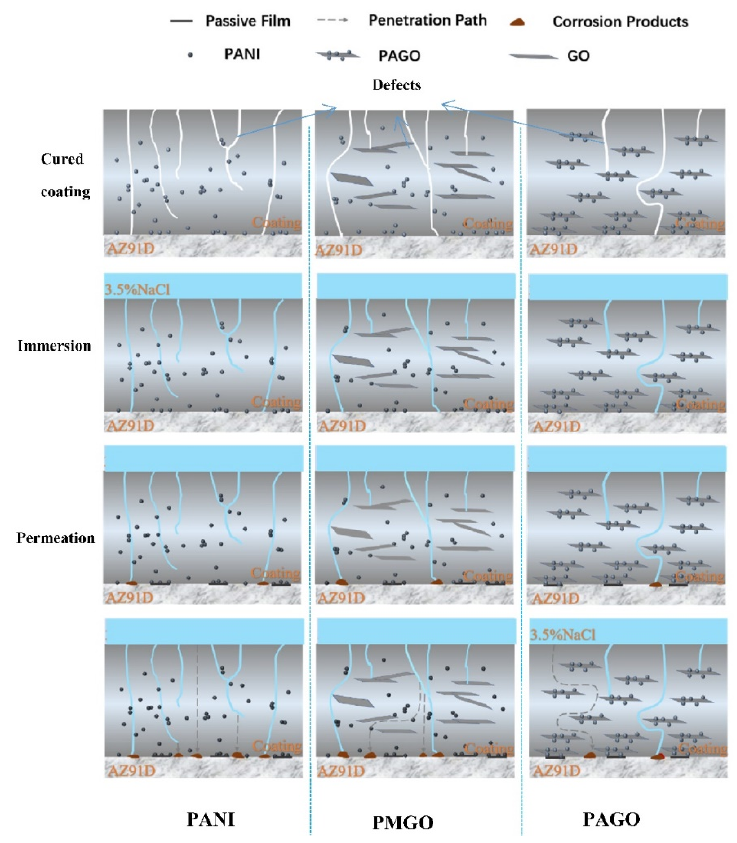
Figure 11. Schematic of the protection mechanism of different coatings.